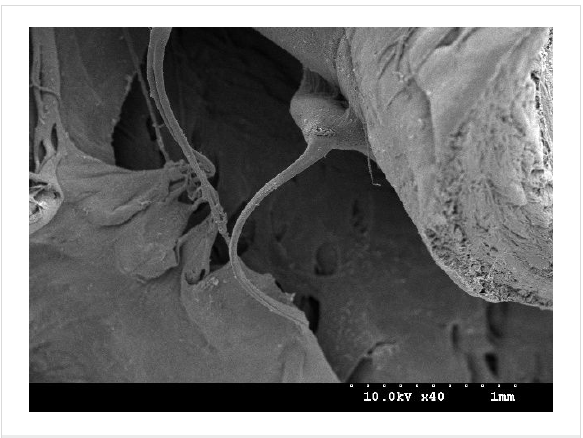
Figure 4: The mitral valve of the